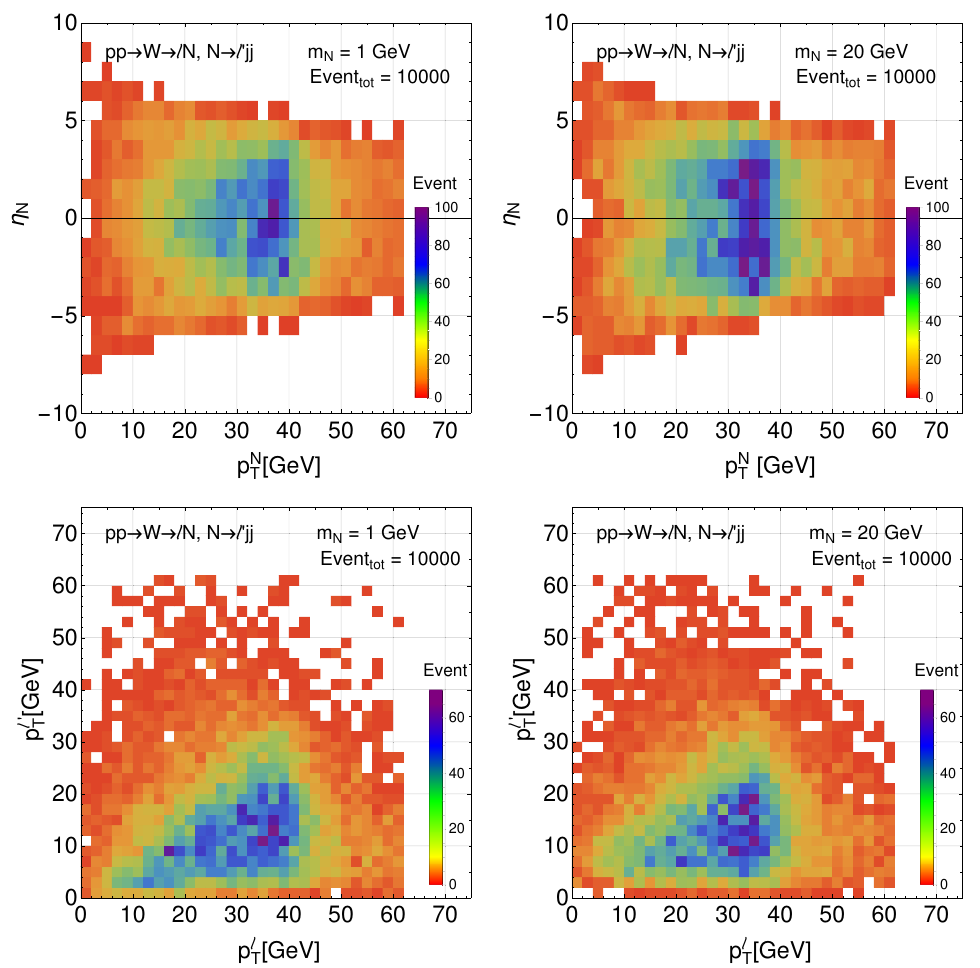
Figure 2 . Kinematics of the signals from the process pp W (cid:29)N with subsequent decay → → versus the pseudo-rapidity η of the sterile N (cid:29) (cid:31) qq (cid:31) . Top panel : the transverse momentum p N N T → neutrino at the 13 TeV LHC. Bottom panel : the transverse momentum distribution of prompt lepton (cid:29) and the displaced lepton (cid:29) (cid:31) . For the distributions, we have used mass m N = 1 GeV and 20 GeV shown in the left panels and right panels, respectively. The total number of events is 10000, which 8 at integrated luminosity corresponds to sin 2 θ = 5 . 5 10 = 3 ab − 1 for HL-LHC. − × L